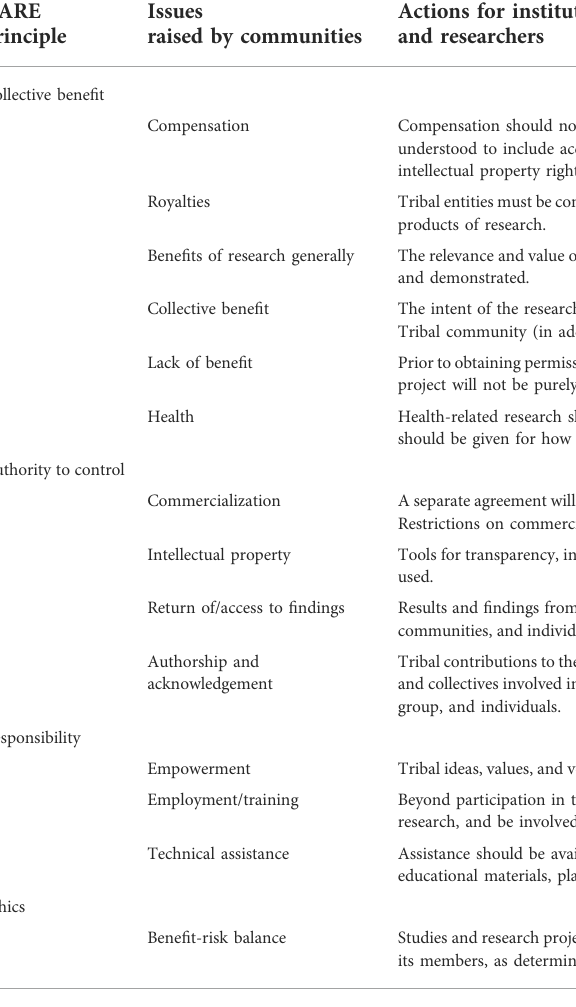
TABLE 2 Operationalizing the CARE principles: Tribal expectations for bene fi t